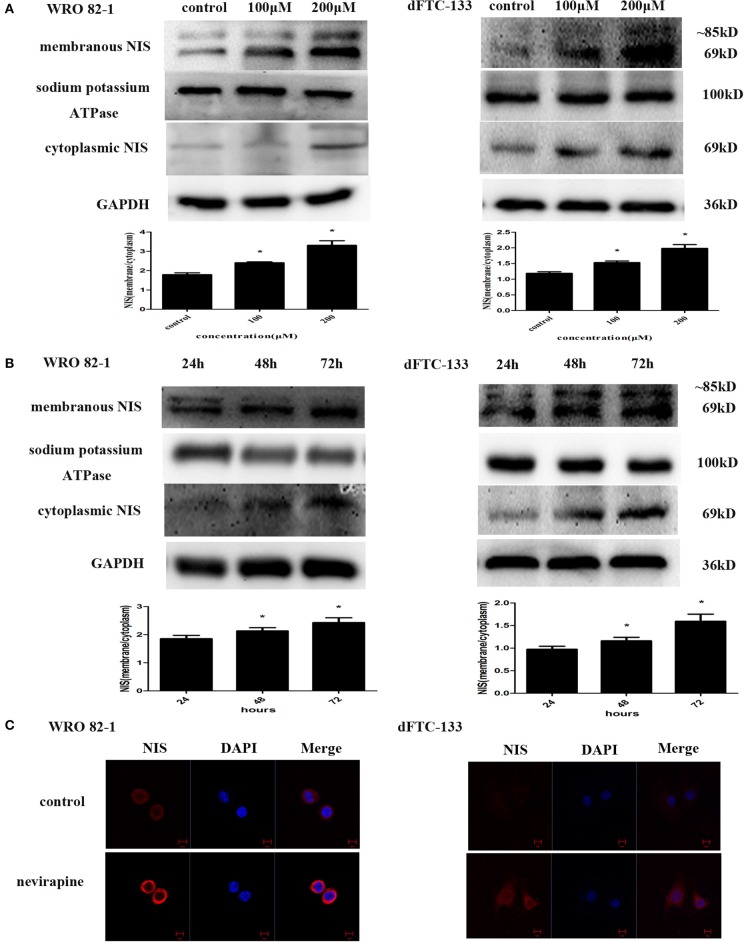
Nevirapine up-regulated cytomembrane-localized NIS protein in WRO 82-1 cells and dFTC-33 cells. (A) Protein expression of membranous and cytoplasmic NIS in WRO 82-1 and dFTC-133 cells treated by nevirapine for 72 h was determined by western blot analysis and analyzed quantitatively. Sodium potassium ATPase and GAPDH were used as the loading control. Data are shown as the mean ± SD of three experiments. (B) The expressions of NIS protein in cytomembrane and cytoplasm in both cells with 200 μM nevirapine in time course experiments were determined by western blot analysis with quantification. (C) Immunofluorescence of NIS protein in WRO 82-1 and dFTC-133 cells by 200 μM nevirapine for 72 h was detected by confocal microscope. Scale bar represents 10 μm. *P < 0.05 vs. control.